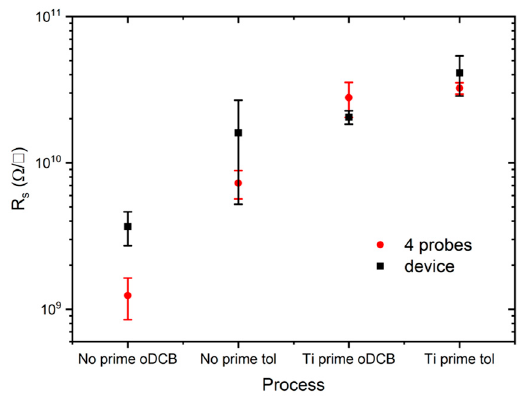
Figure 5. Sheet resistances extrapolated from a set of five devices for each process (black symbols) and measured with the four probes method on the other five samples for each process (red symbols). Devices fabricated starting from oDCB solution generally show higher conductivity with respect to those fabricated with toluene. Ti prime improves reproducibility but reduces the conductivity independently on the solvent.